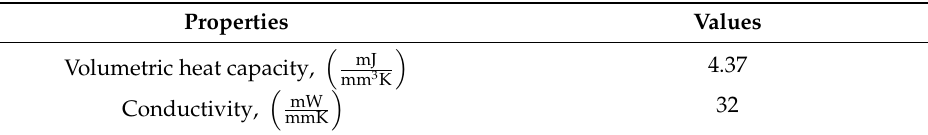
Figure 4. FLCs for USIBOR ® 1500. Table 4. Thermal properties for USIBOR ® 1500.